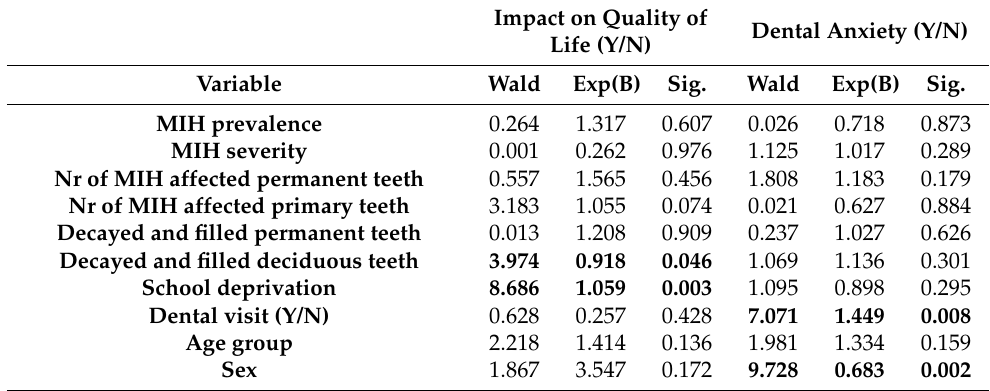
Table 2. Results of the binary logistic regression on variables associated with impact on quality of life and dental anxiety. The significance ( p value) according to the Wald test (Wald) is provided, as is the relative risk (Exp(B)). Values in bold are significant. Impact on Quality of Dental Anxiety (Y/N) Life (Y/N) Variable Wald Exp(B) Sig. Wald Exp(B) Sig. MIH prevalence 0.264